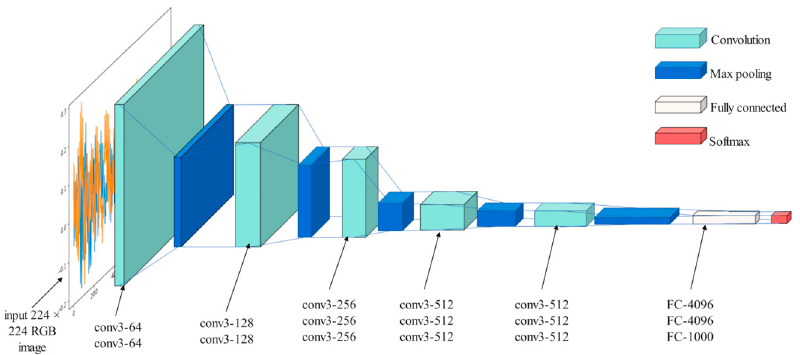
Figure 1. VGG network